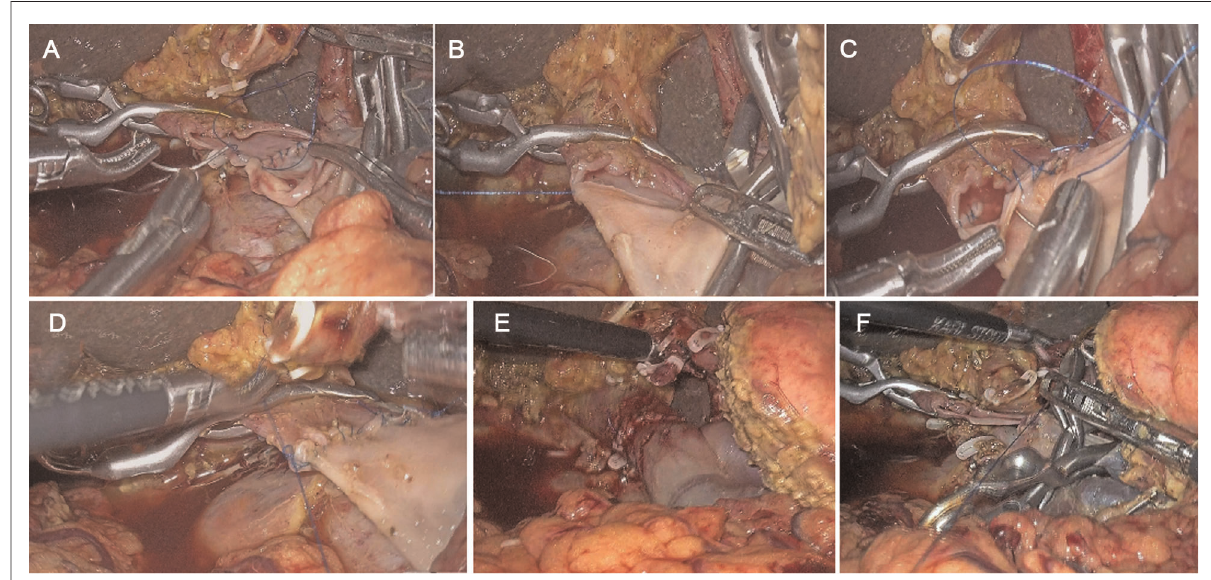
FIGURE 1 Anastomosis process of laparoscopic pancreatoduodenectomy (LPD) combined with major venous resection and reconstruction. ( A ) Interrupted suture on the left side of the extravascular and knotted; ( B ) continuous suture on the posterior wall of the blood vessel; ( C ) completion of continuous suture on the posterior wall; ( D ) continuous suture on the anterior wall; ( E ) completion of continuous suture on the anterior wall; ( F ) no stenosis of vessel after